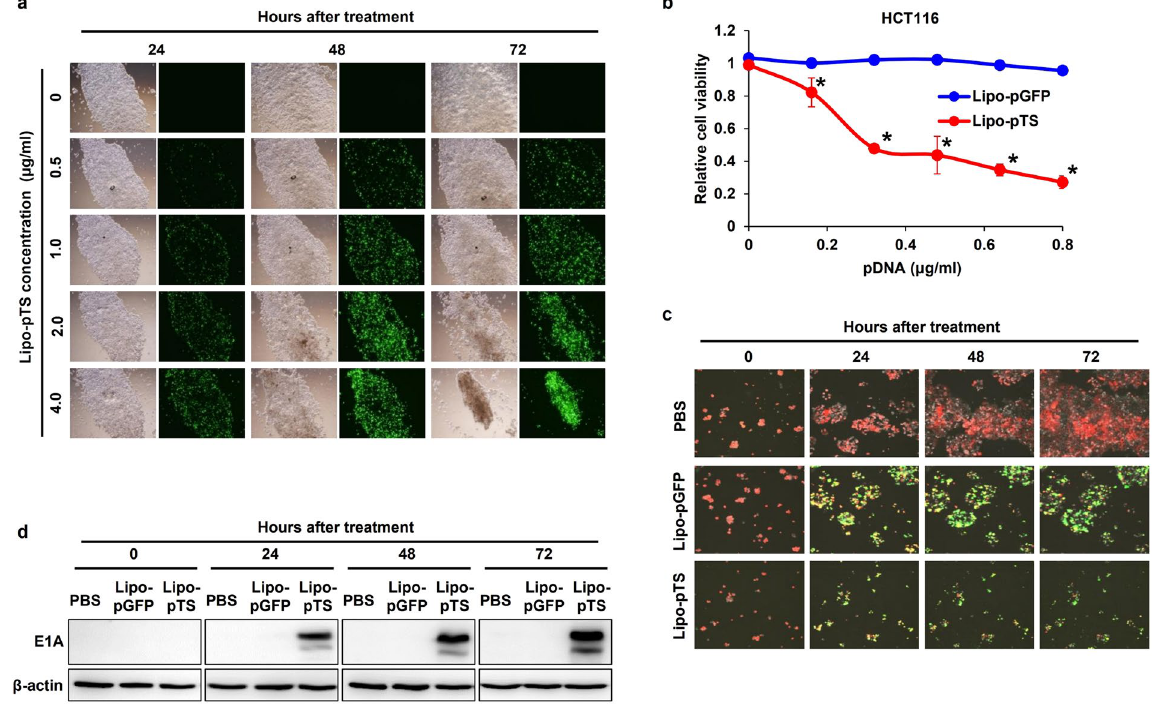
Figure 2. Infectivity and cytotoxicity of Lipo-pTS. ( a ) HCT116 cells are treated with different concentrations of Lipo-pTS for 24, 48, or 72 hours, and the infectivity, shown as GFP spots, is observed on fluorescence microscopy. ( b ) HCT116 cells are treated with several concentrations of Lipo-pTS or Lipo-pGFP for 3 days, and cell viability is assessed by the XTT assay. The percentage of viable cells relative to liposome-treated cells at each concentration is plotted. Error bars indicate 95% confidence intervals. * p < 0.01. ( c ) HCT116-RFP cells (red) are treated with Lipo-pTS, Lipo-pGFP, or PBS, and time-lapse images are taken at each 60 minutes for 3 days. Images at 0, 24, 48, and 72 hours are shown. ( d ) Western blot analysis of adenovirus type 5 E1A protein in whole cell lysates of HCT116 cells collected at 24, 48 or 72 hours after treatment with PBS, Lipo-pGFP or Lipo-pTS. The images were cropped from different blots run under the same experimental conditions. The original blots were presented in Supplementary Fig.